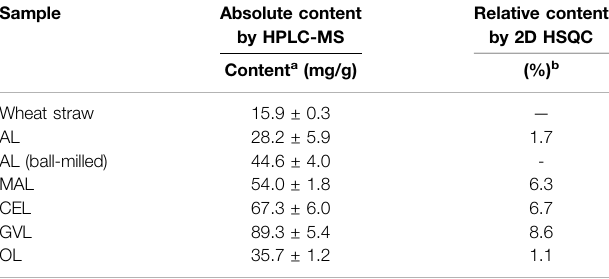
TABLE 3 | The content of tricin in different lignin samples. TABLE 4 | Sun protection factors (SPF) and DPPH free radical scavenging ability of different